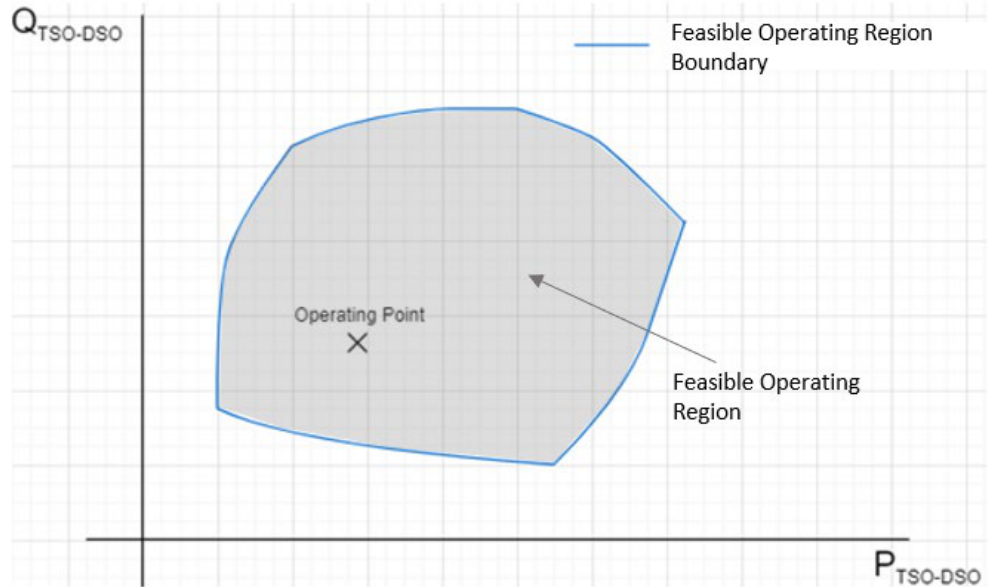
Figure 1. A typical FOR.